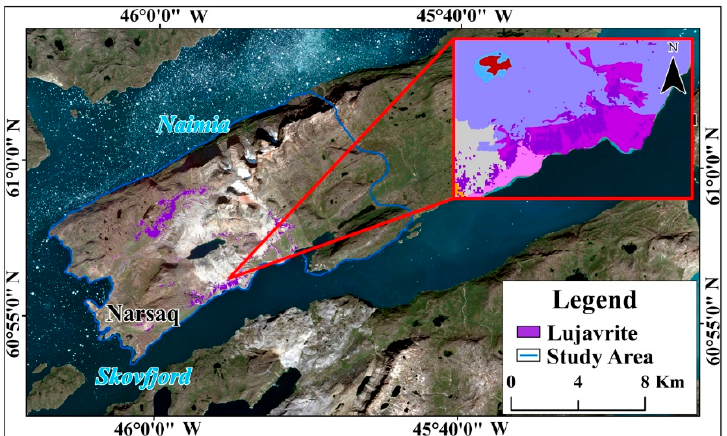
Figure 11. SVM Lithology classification map (the base image is a combination of Worldview-2 ′ s 321 bands).